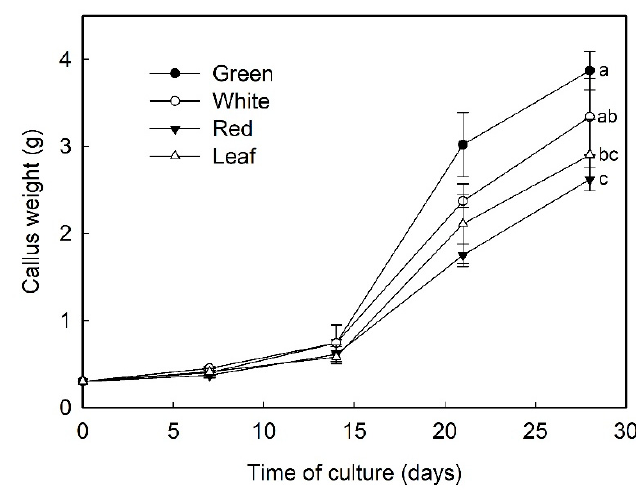
Figure 3. Growth curve of the different callus lines obtained from leaf and fruit receptacle at green, white, and red stages. Data represent mean ± SD. At 28 days of culture, means with different letters indicate significant differences by Tukey test at p = 0.05.